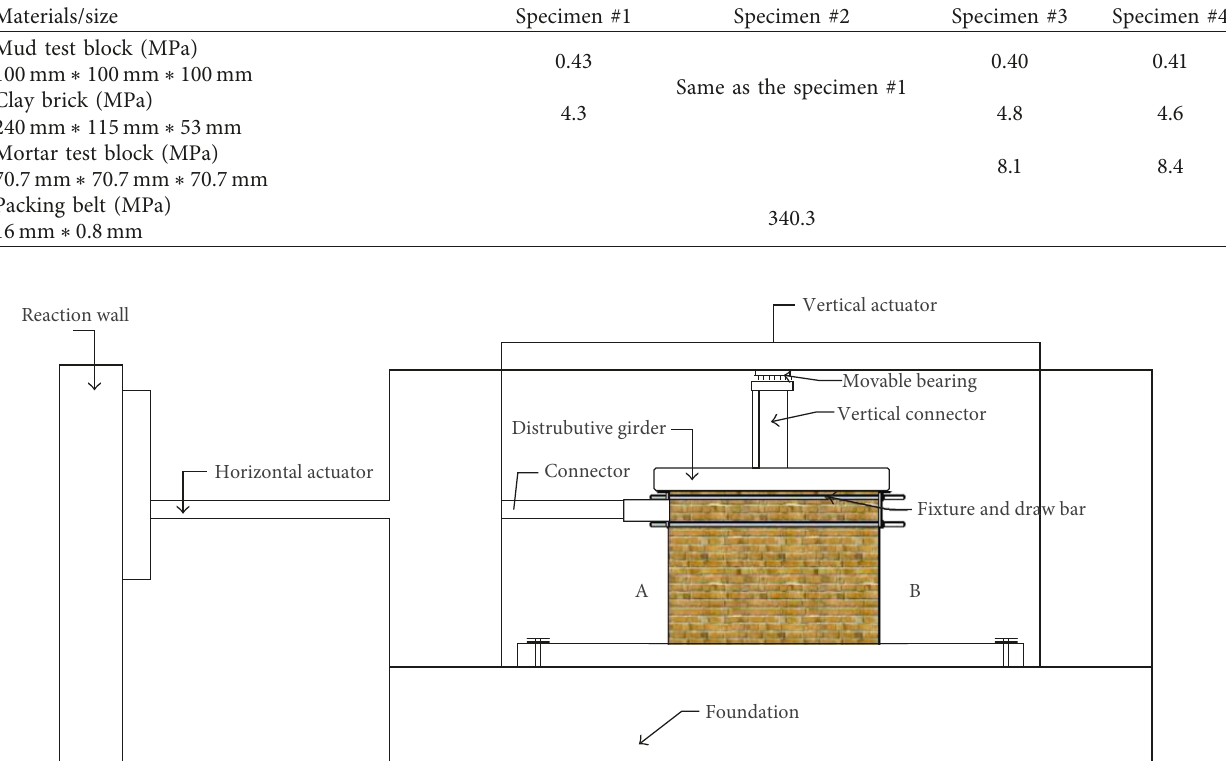
Table 2: The strength of the materials.